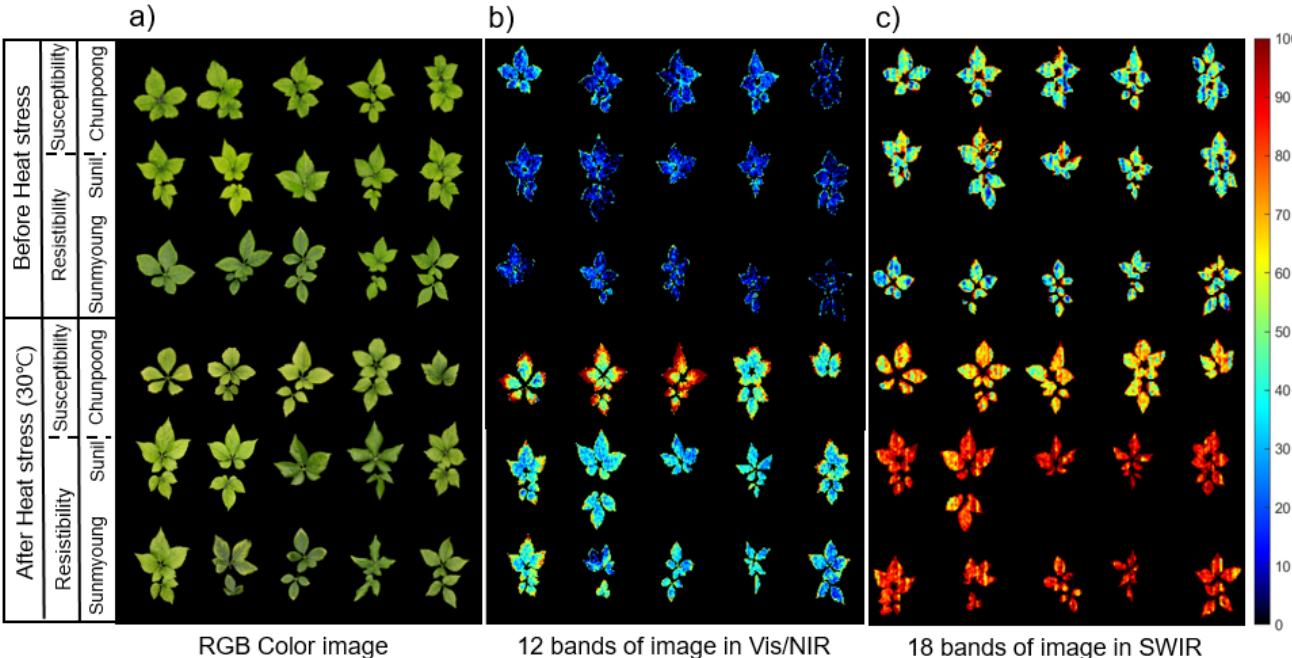
Figure 6. Comparison of color image and the resultant PLS-DA image using selected waveband images in Vis/NIR and SWIR. ( a ) Color image. ( b ) PLS-DA image constructed by 12 bands of spectral image in Vis/NIR and ( c ) 18 bands of spectral image in SWIR.